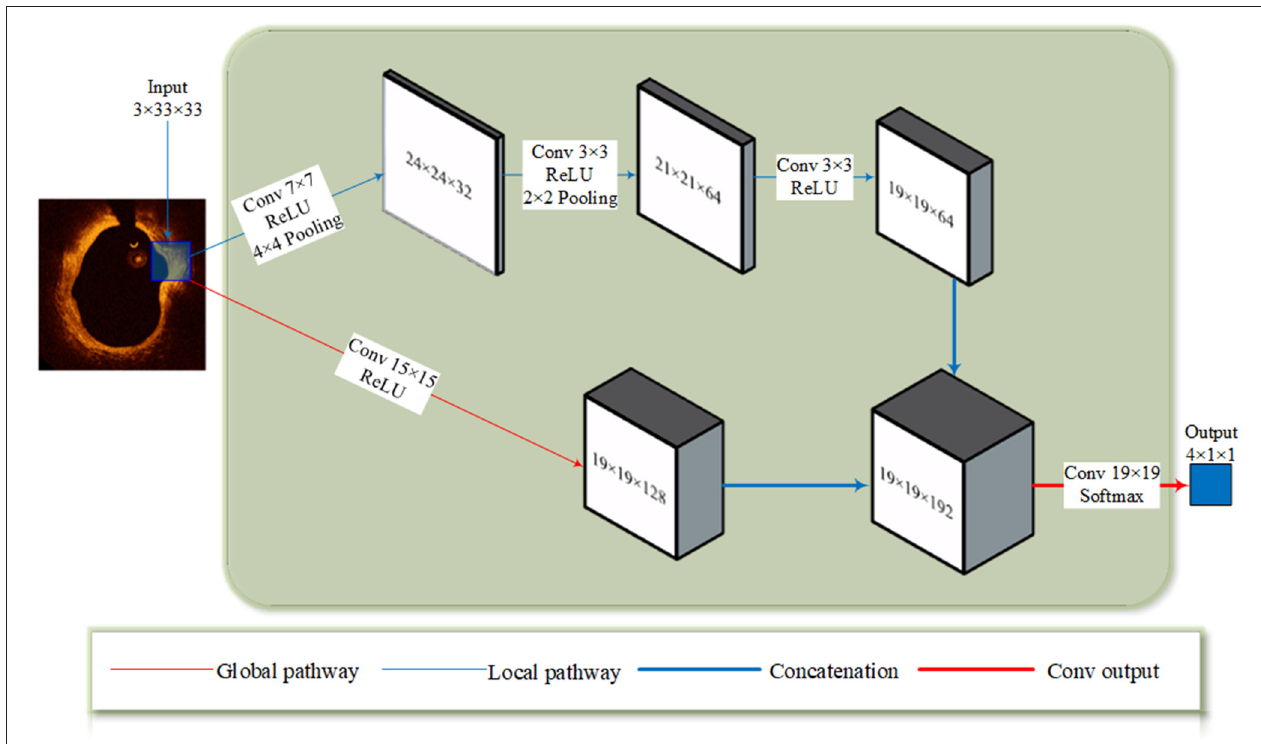
FIGURE 2 | The TwoPathCNN architecture. The input patch goes through a global pathway (marked with a thin red line) and a local pathway (marked with a thin blue line) with convolution. The feature maps produced by two pathways are concatenated together (marked with a thick blue line) and it goes through a convolutional output layer (marked with a thick red line) to obtain the